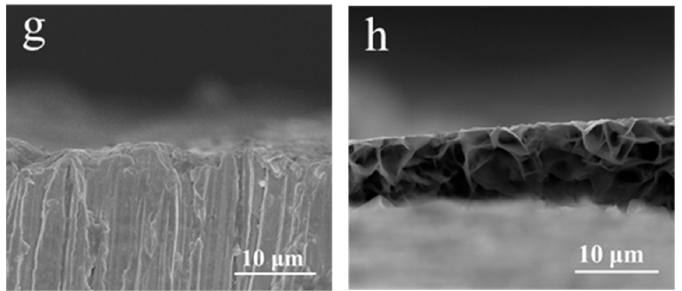
Figure 1. Scanning electron microscopy (SEM) images of ( a , b ) copper surface treated with H 3 PO 4 solution; ( c ) copper surface with 1-dodecanethiol self-assembled monolayers (SAM); ( d , e ) copper